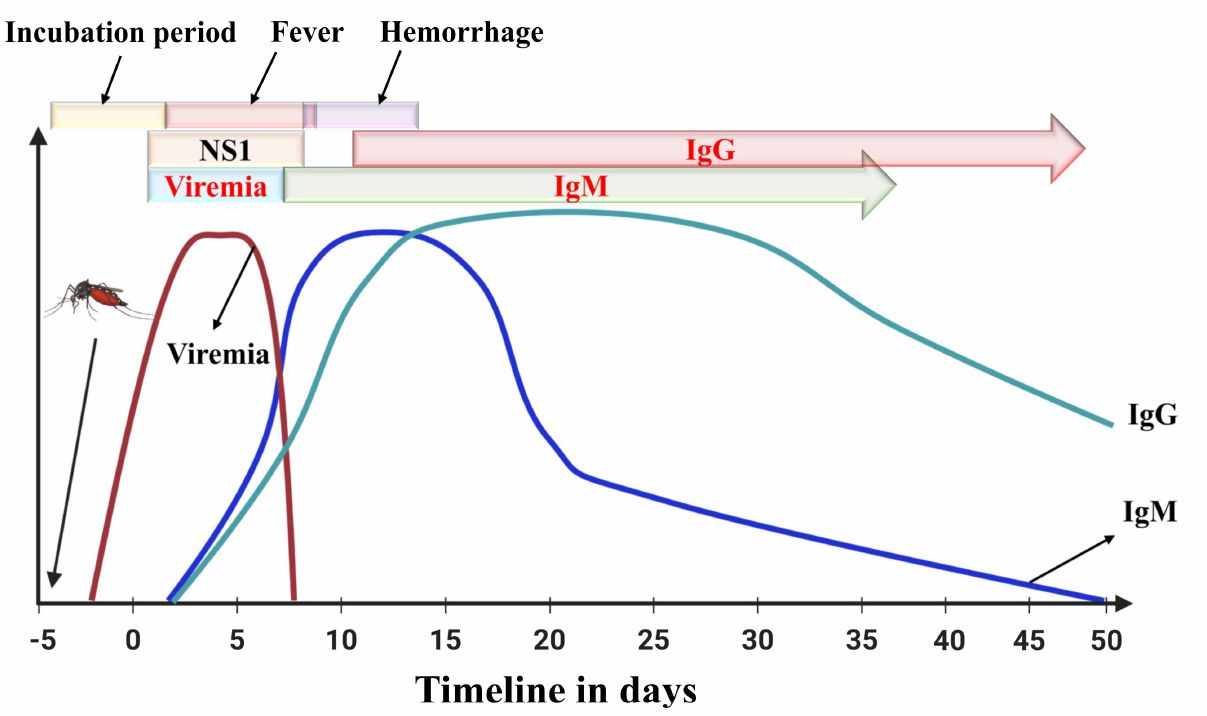
Figure 3. Immune response by the human body against the first invasion of the Dengue